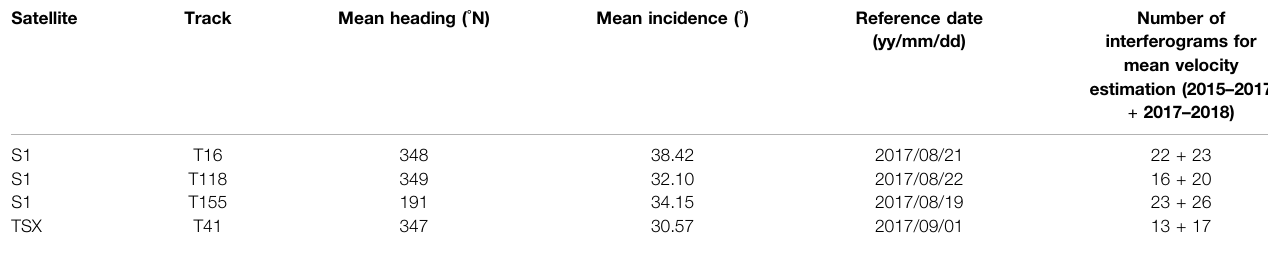
TABLE 1 | Main characteristics of the SAR tracks used in this study: Strip-Map T41 track from TerraSAR-X satellite and Interferometric Wide-Swath T16, T155 and T118 tracks from the Sentinel-1 constellation. Satellite